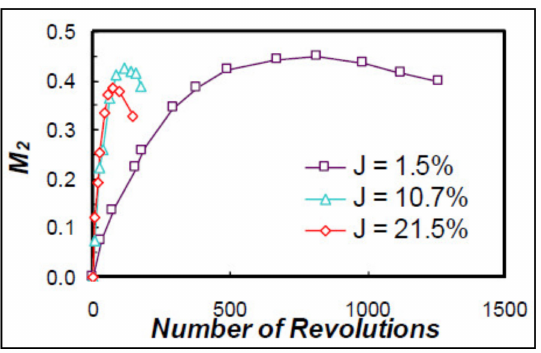
Figure 3. Mass fraction of m 2 versus the number of revolutions